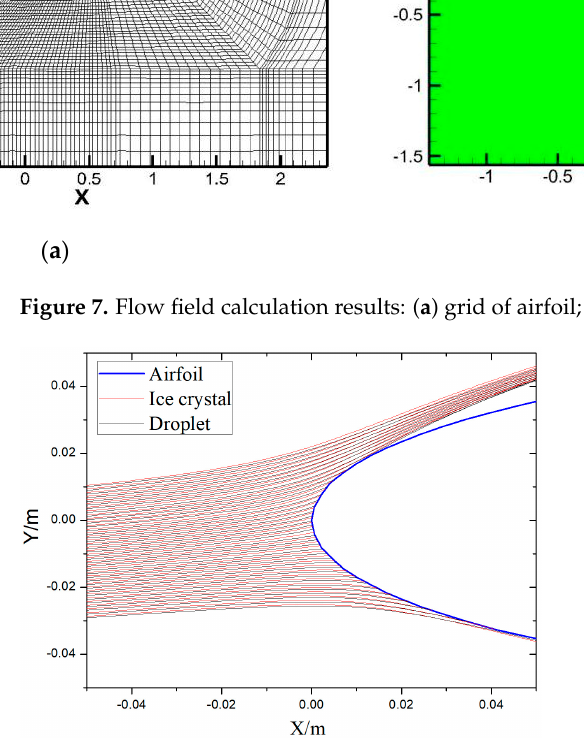
Figure 8. Comparison of the trajectories of ice crystals and droplets.